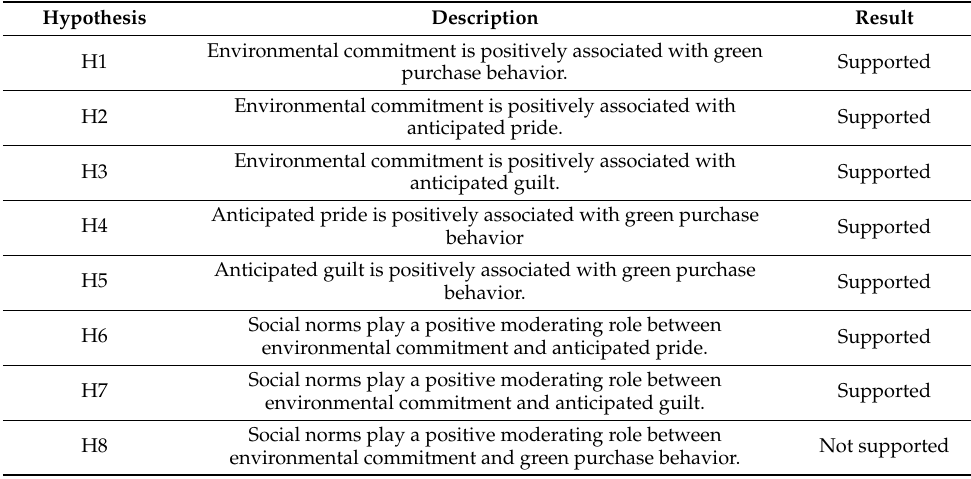
Table 5. Summary of the results for each